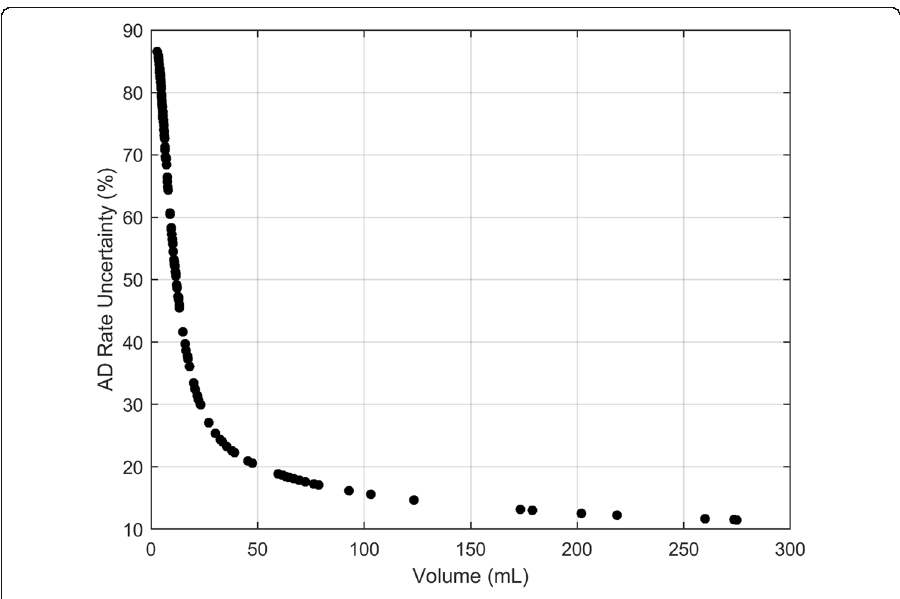
Fig. 5 Absorbed dose rate uncertainty (%) against volume (mL)